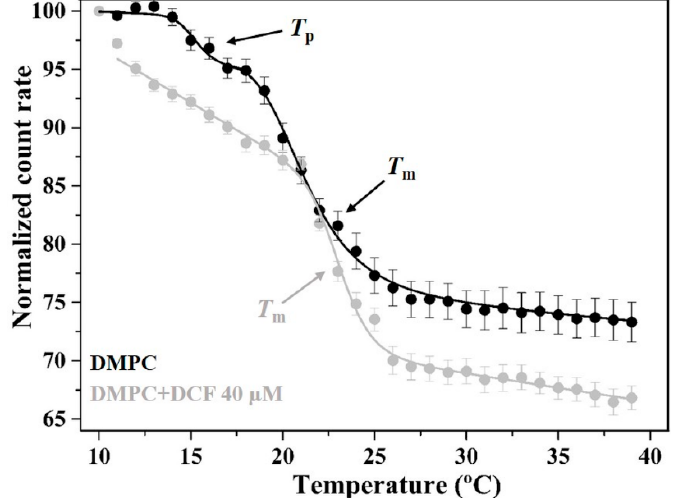
Figure 4. Normalized count rate of DMPC lipid vesicles unloaded and DCF-loaded (40 μ M) as a function of temperature. Continuous lines are the best-fitted curves according to Equation (8). Values reported are the mean ± standard deviation of three replicate samples. T p and T m stand for pre-transition temperature and main phase transition temperature, respectively.